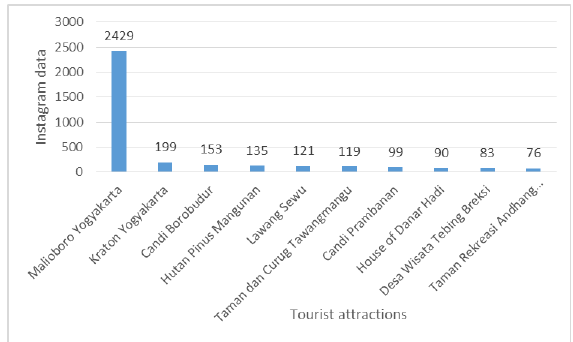
Figure 4.5 Graphic popular tourist